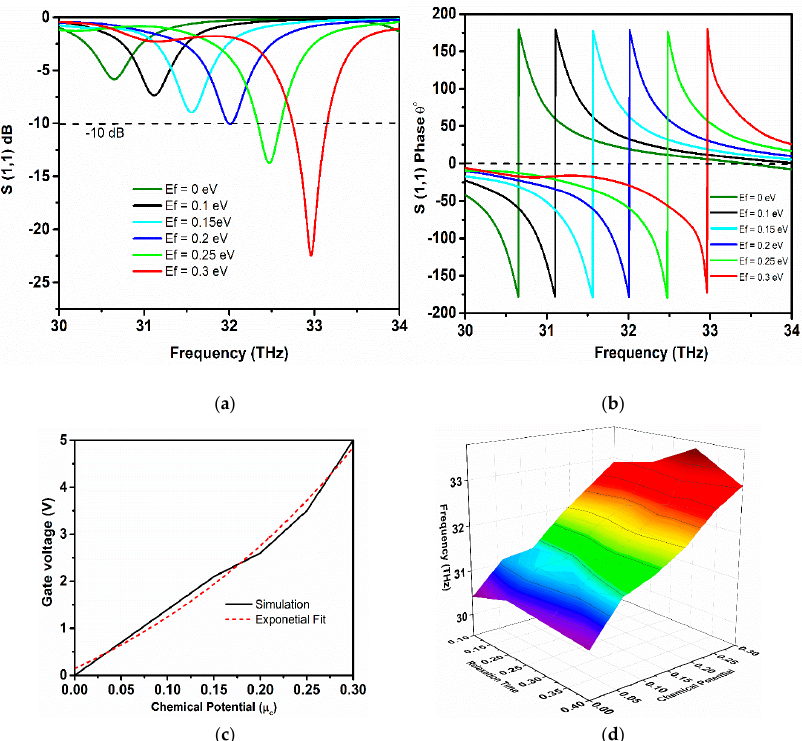
Figure 6. ( a ) Reflection coefficient of the proposed graphene-metal antenna with varying chemical potential ranging from 0 eV to 0.3 eV; ( b ) Reflection phases of S 11 with varying chemical potential; ( c ) Tuning of chemical potential with respect to varying gate voltage; and, ( d ) three-dimensional (3D) graph of resonance frequency tuning with respect to chemical potential and relaxation time.